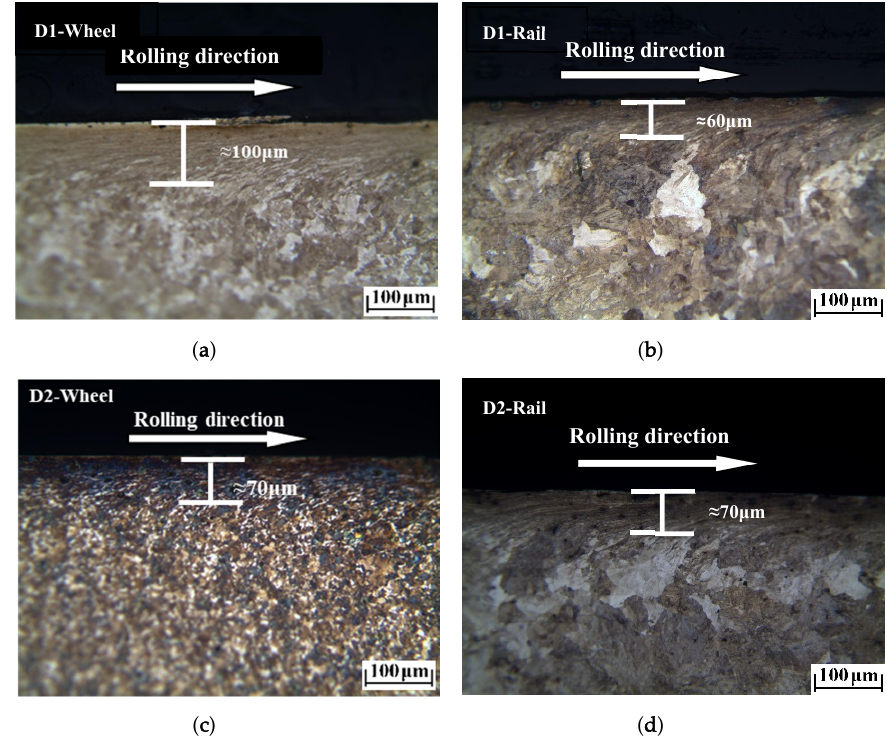
Figure 9. Plastic deformation of wheel and rail rollers at 50 °C: (a) D1 wheel; (b) rail of D1 friction pair; (c) D2 wheel; (d) rail of D2 friction pair.